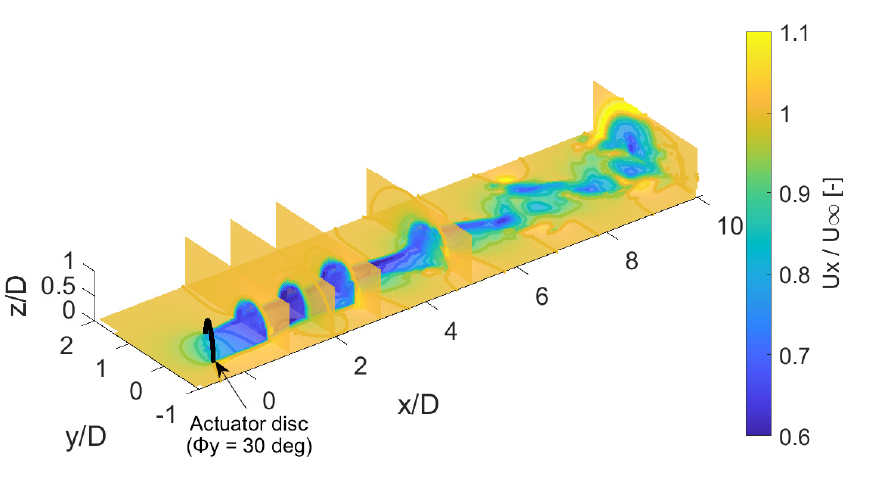
Figure 1. The upper part of the actuator disc and normalized velocity field around disc and in the wake, when base C T = 0.6, harmonic ∆ C T = ± 0.1, Φ y = 30 deg, f r = 0.1, where C T is the trust coefficient, ∆ C T is the change of the trust coefficient, Φ y is the yaw angle, and f r is the reduced (cid:16) (cid:17) ω R frequency U